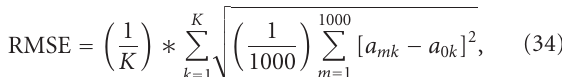
Figure 5: Angle estimation performance comparison at M = 12, K = 4, P = 3, and N =